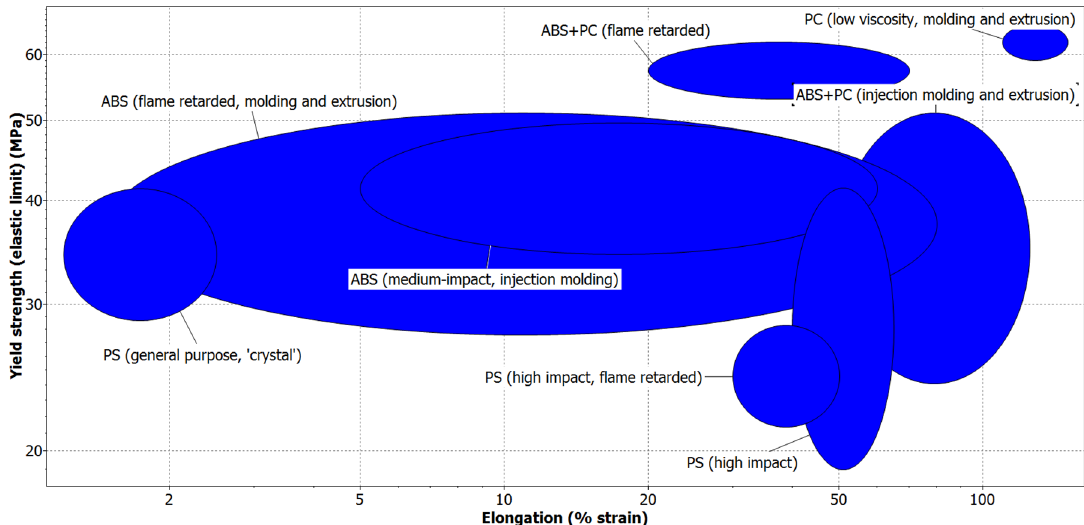
Figure 3. Values chart of the Yield Strength and the Elongation of CES (Cambridge Engineering Selector). as the addition of cis-butadiene, one of the main elastomers found in